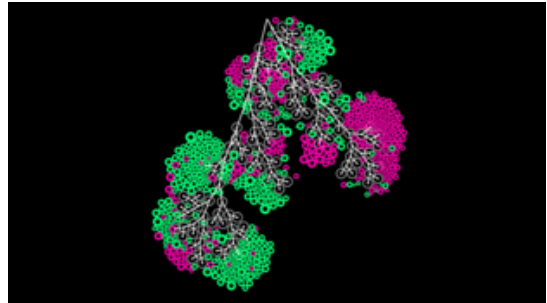
Figure 14 | Tree structure of the algorithm showing two prediction classes and mistakes in